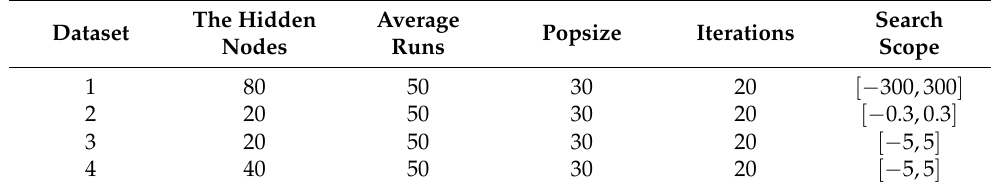
Table 7. Parameters setting for performance